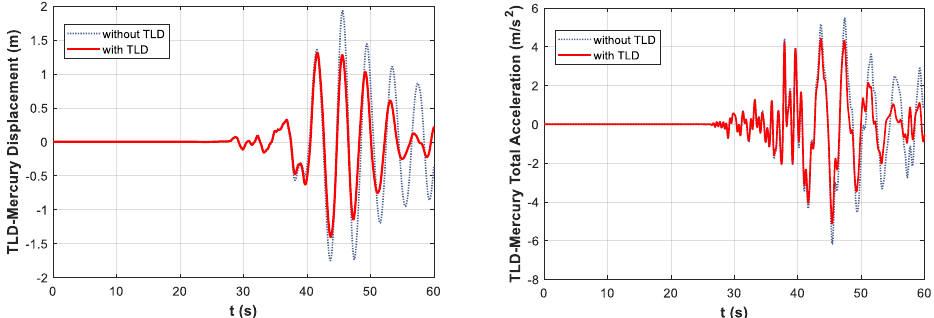
Figure 16. AHS optimization of the 40-story structure displacement–time and total acceleration–time graphs in the CHICHI/CHY101-N earthquake record for TLD–mercury.